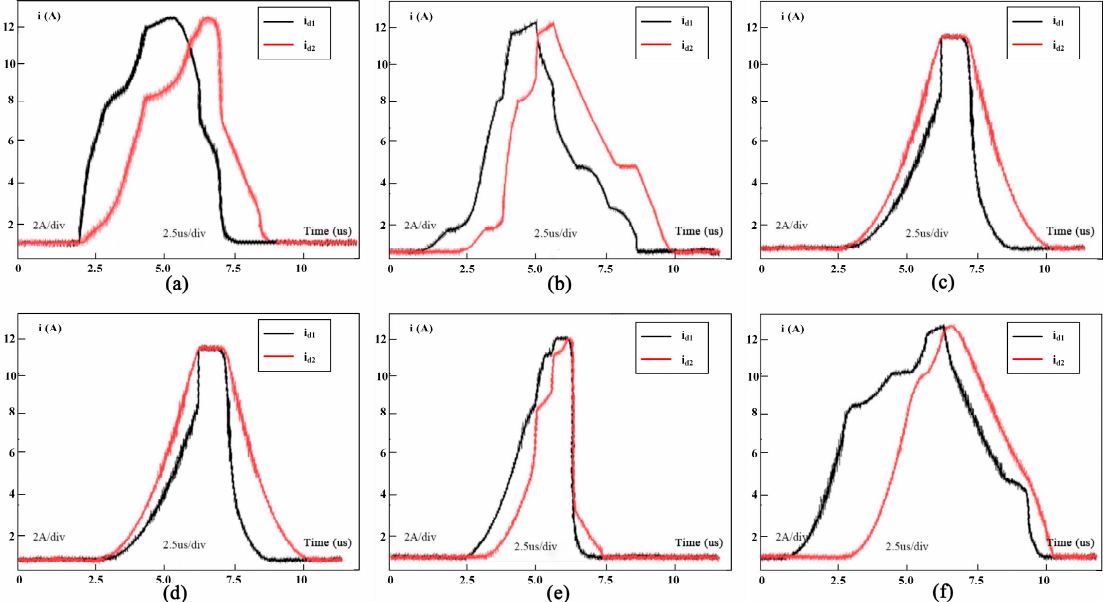
Figure 19. Parallel current imbalance suppression waveform of a single ferrite inductor on parasitic parameters: ( a ) suppression waveform of L g ; ( b ) suppression waveform of L d ; ( c ) suppression wave- form of L s ; ( d ) suppression waveform of C gs ; ( e ) suppression waveform of C gd ; and ( f ) suppression waveform of C ds .